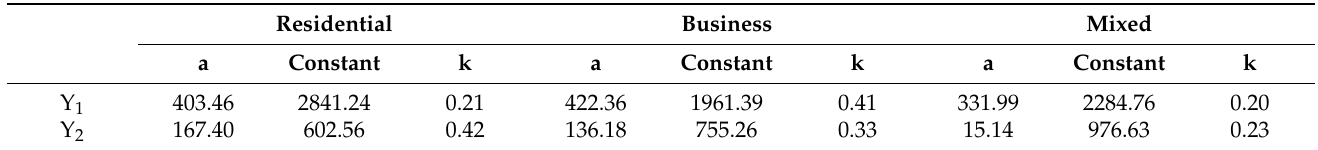
Table 3. Corresponding